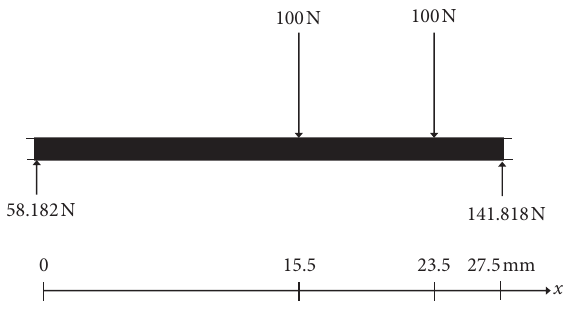
Figure 6: Free-body diagram demonstrating base length as rep- resented by the sum of each replacement tooth and implant.